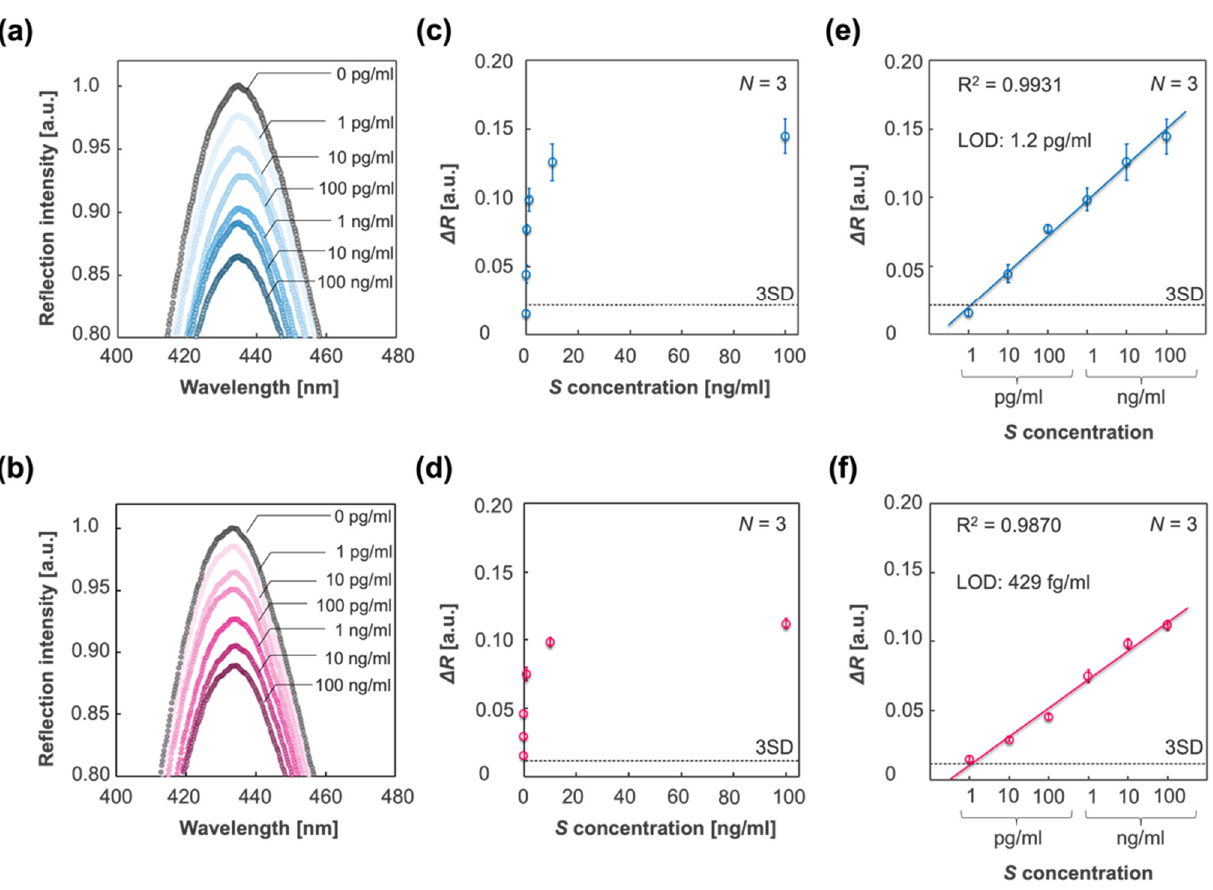
Figure 5. Detection and quantification of spike proteins in different sample solutions. ( a , b ) Reflection spectra of the IPCF before (black plots) and after incubation in respective sample solutions containing spike proteins with different concentrations of 1 pg/mL to 100 ng/mL: PBS (blue scaled plots) and A. saliva (magenta scaled plots). ( c , d ) Plots of responses to each spike protein concentration in the cases of PBS ( c ) and A. saliva ( d ). ( e , f ) Calibration curve of the response to spike protein concentration in the cases of PBS ( e ) and A. saliva ( f ). The three times standard deviation (3SD) lines are displayed, and the limit of detections (LOD) based on the 3SD values are described. Triplicate measurements with independent chips were conducted ( N = 3).